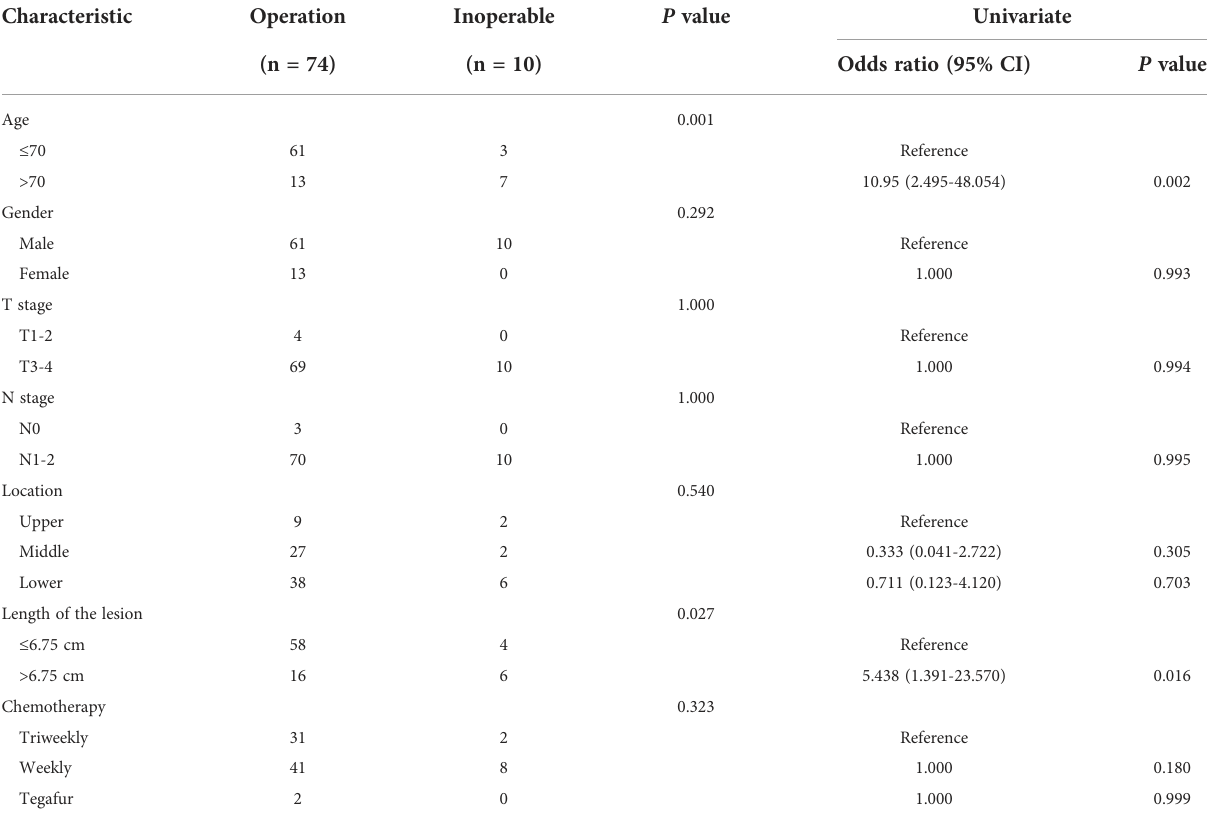
TABLE 1 Patient characteristics between inoperable and operative